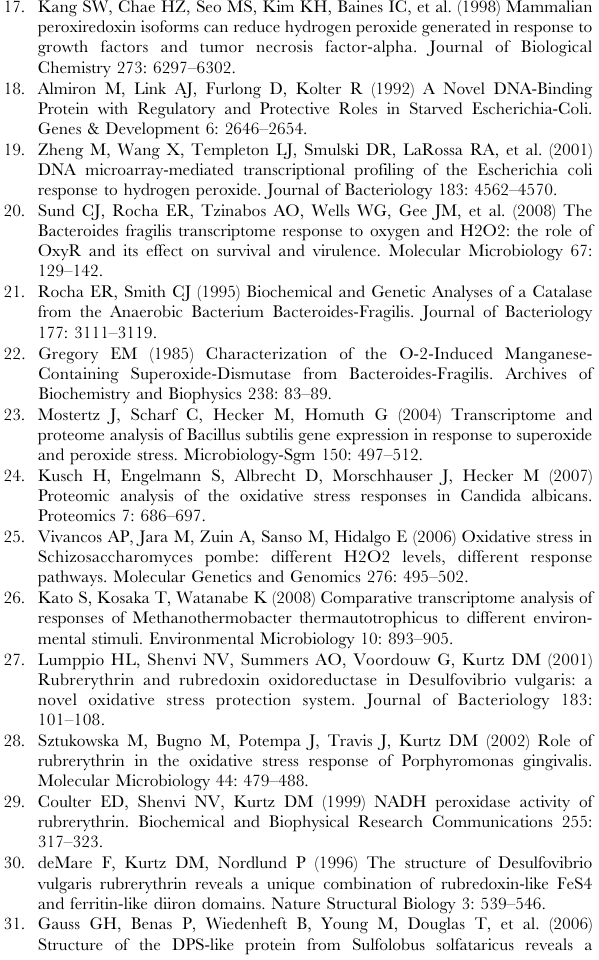
Table S3 Sulfolobus solfataricus regulated proteins